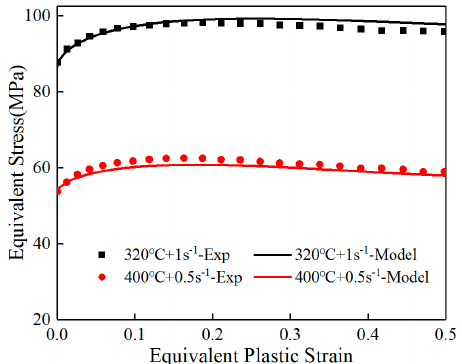
Figure 9. The comparison results between the experimental data and the predictions.